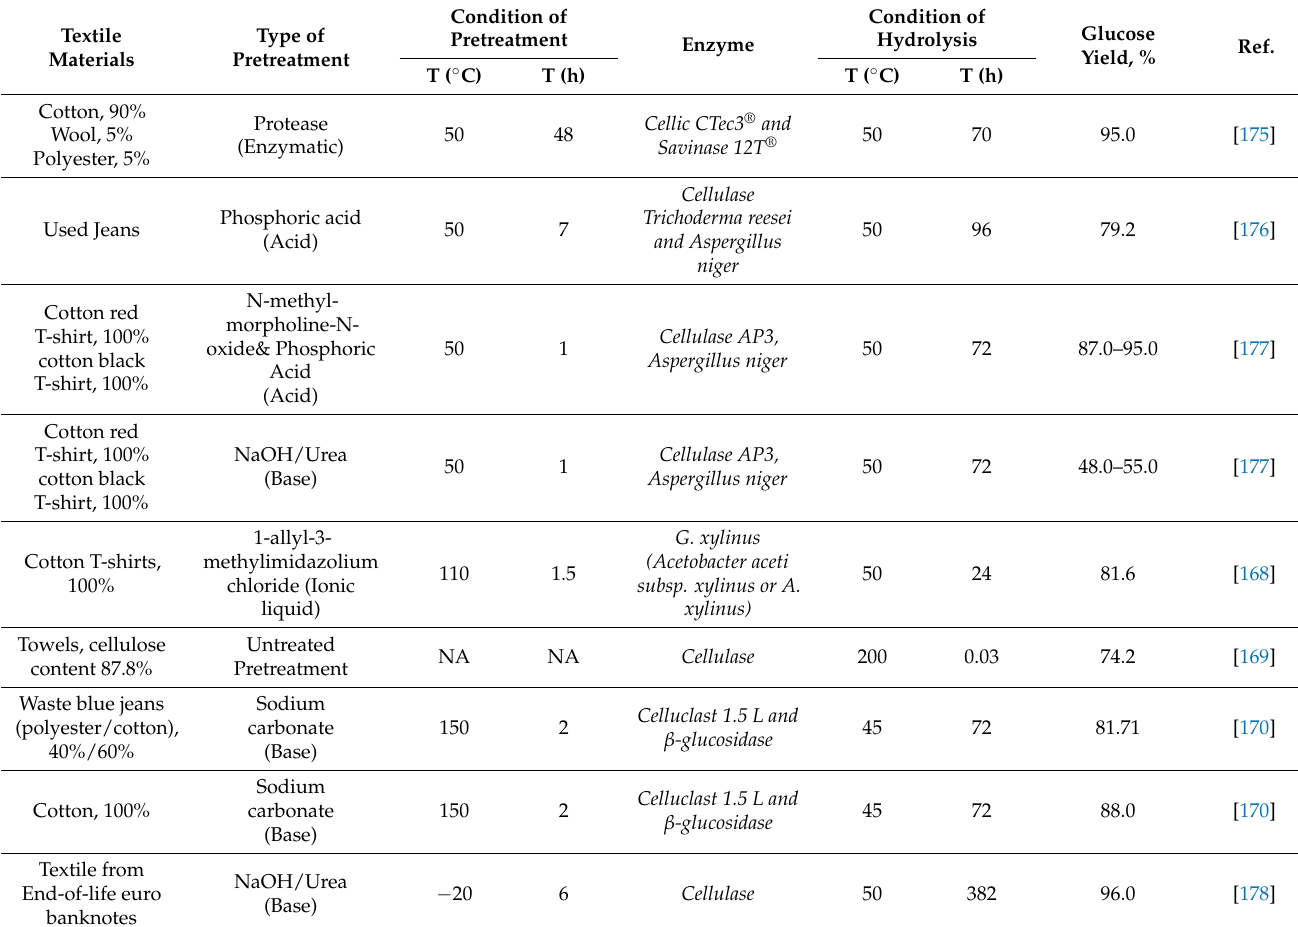
Table 5. Conditions for converting textile fiber to glucose via enzymatic